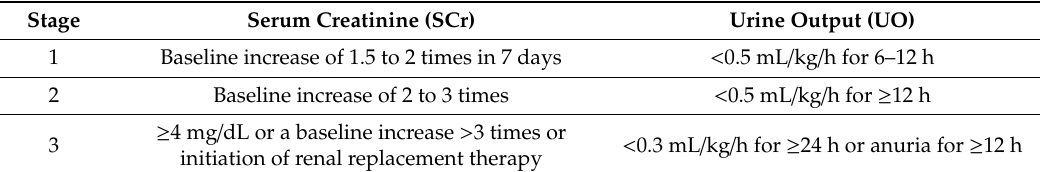
Table 1. KDIGO classification criteria for acute kidney injury. Abbreviation: KDIGO, Kidney Disease: Improving Global